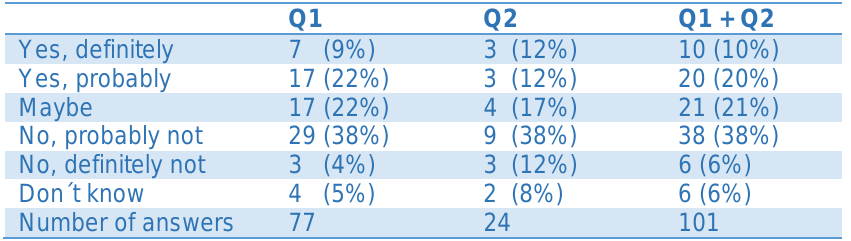
Table 7: Statement. Cost overruns would be considerably less if it hard larger consequences for those responsible